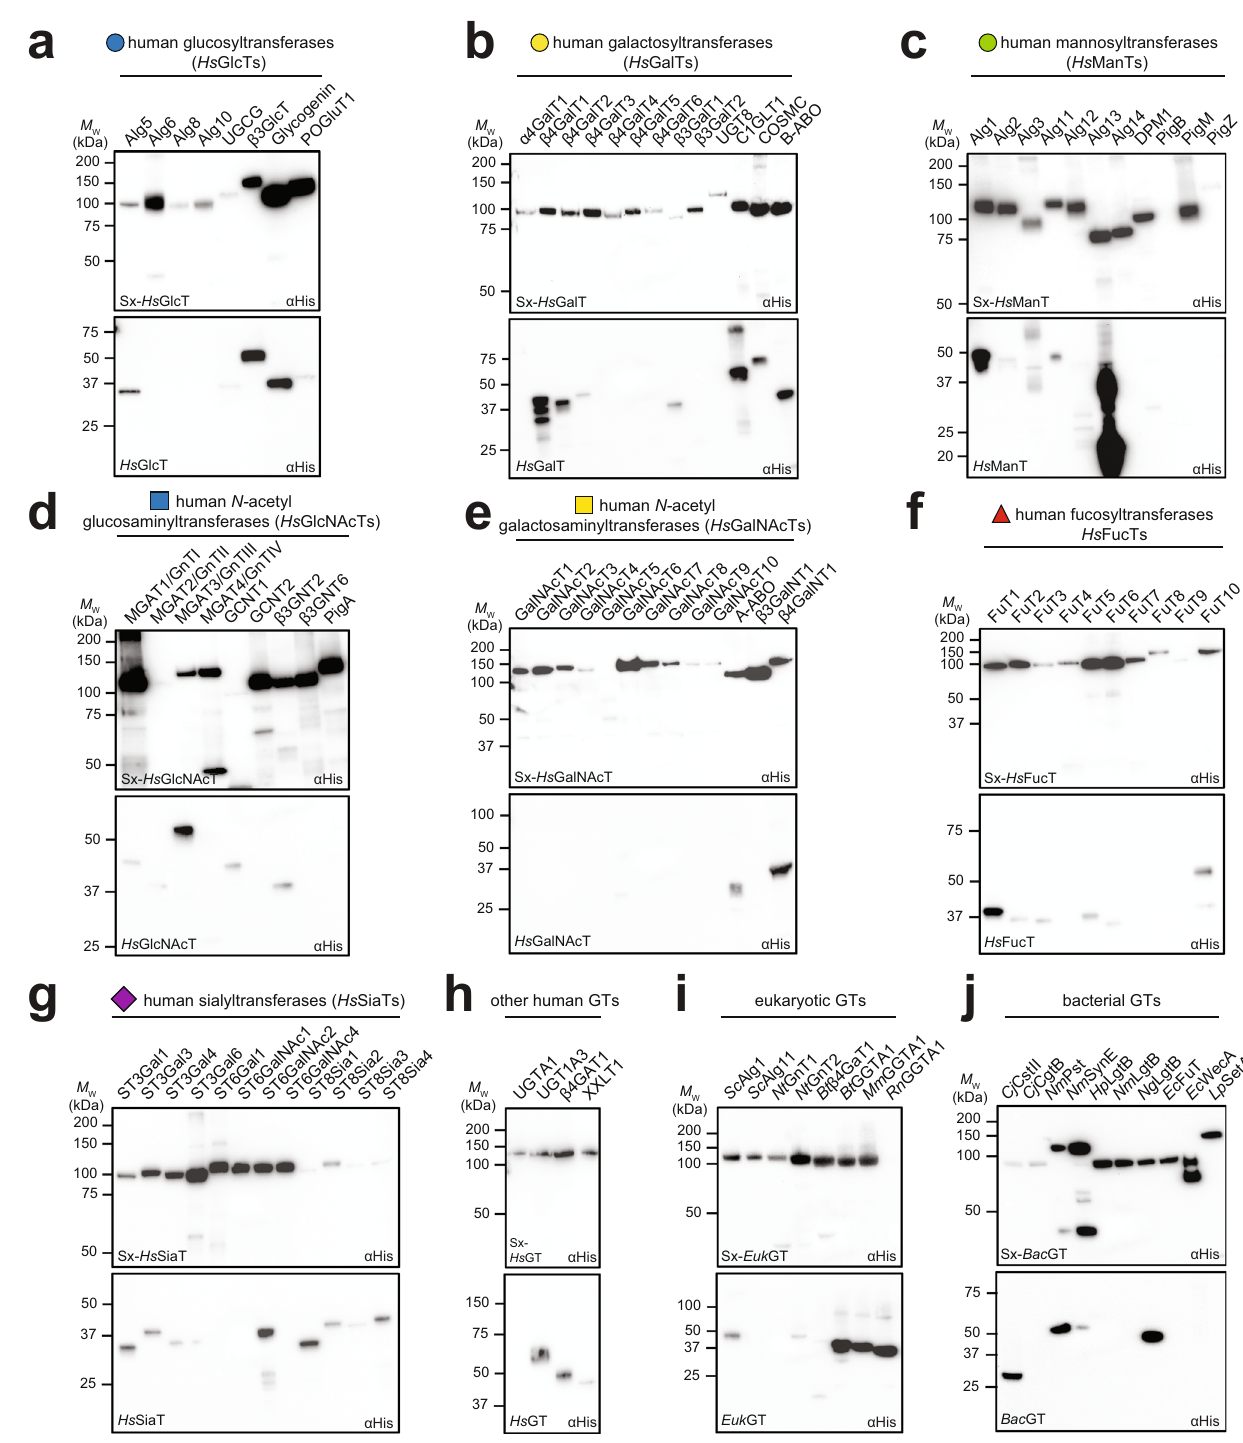
Fig. 2 | Soluble expression of Sx-GT constructs in the E. coli cytoplasm. Ninety- eight GTs were evaluated for soluble, cytoplasmic expression in the SIMPLEx fra- mework.ImmunoblotanalysisofsolublefractionsderivedfromeitherBL21(DE3)or SHuf fl e T7 Express cells carrying plasmids for Sx-GT (top blot in each panel) or unfused GT (bottom blot in each panel) constructs. GTs were clustered according to origin and activity asfollows: a humanglucosyltransferases ( Hs GlcTs); b human galactosyltransferases ( Hs GalTs); c human mannosyltransferases ( Hs ManTs); d human N -acetylglucosaminyltransferases ( Hs GlcNAcTs); e human N -acet- ylgalactosaminyltransferases ( Hs GalNAcTs); f human fucosyltransferases ( Hs FucTs); g human sialyltransferases ( Hs SiaTs); h other human GTs ( Hs GTs);